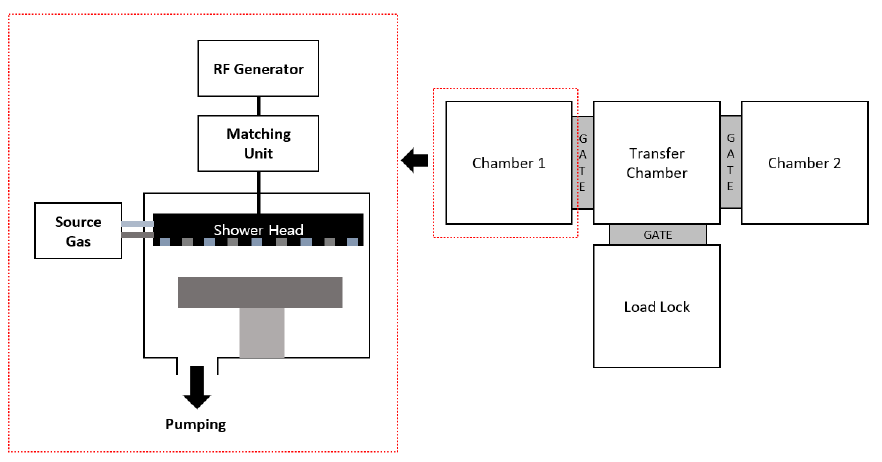
Figure 1. Schematic of plasma-enhanced atomic layer deposition (PEALD) system used for the experiments.